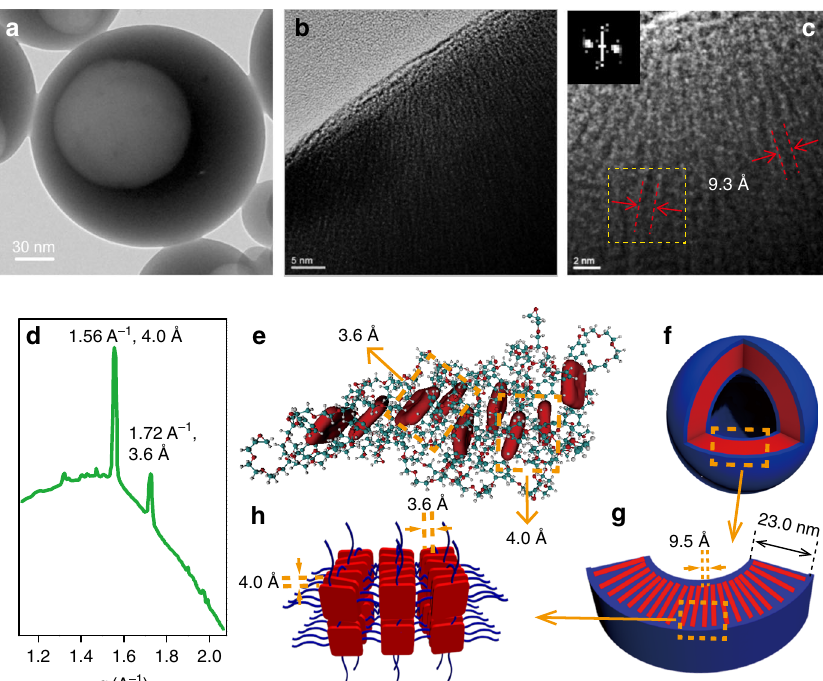
Fig. 3 Proposed membrane structure of THPG vesicles. A representative HR-TEM image ( a ) and the magni fi ed ones ( b , c ) of a single broken THPG vesicle. The inset in c is the fast Fourier transform (FFT) image of selected yellow square area in c . Similar HR-TEM images of THPG were observed for more than three separated samples. d Synchrotron SAXS of THPG vesicles. e The packing model of the porphyrin moieties in THPG vesicles from MD simulation. The red squares in e represent the ZnTHPP moieties. f A diagrammatic drawing of a THPG vesicle. g The magni fi ed membrane cross-section. h The packing model of THPGs in the vesicle